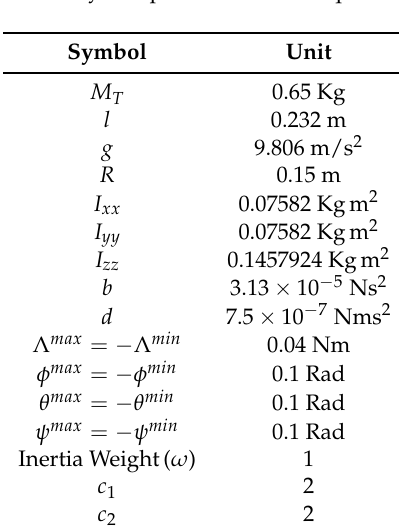
Table 2. Physical parameters of the